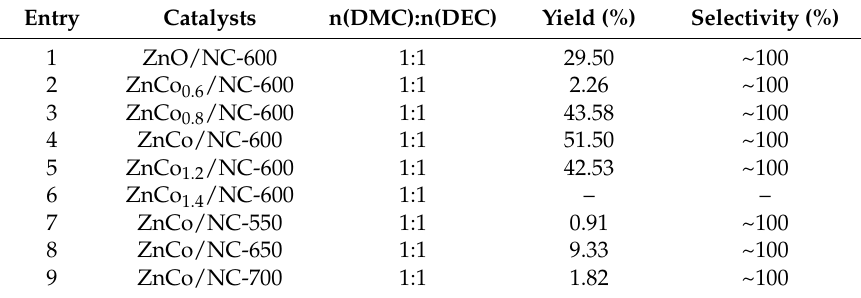
Table 2. Catalytic performance of different catalysts a